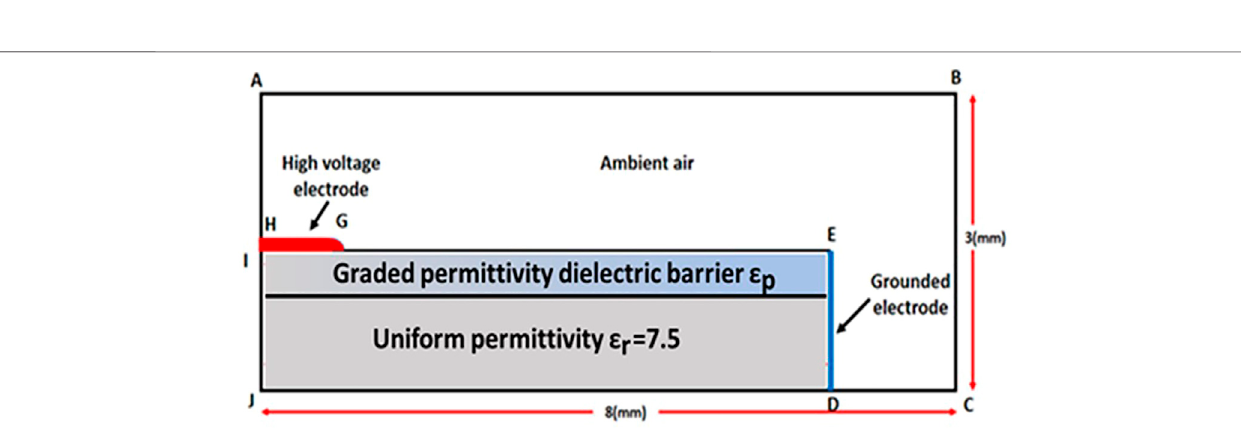
FIGURE 11 | Different thickness of graded permittivity